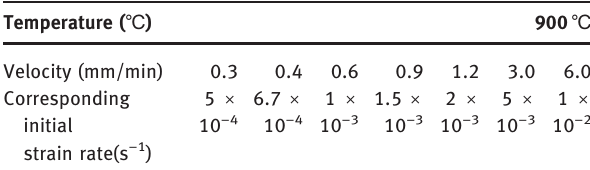
Figure 1: The microstructure of Ti-6Al-4V alloy.